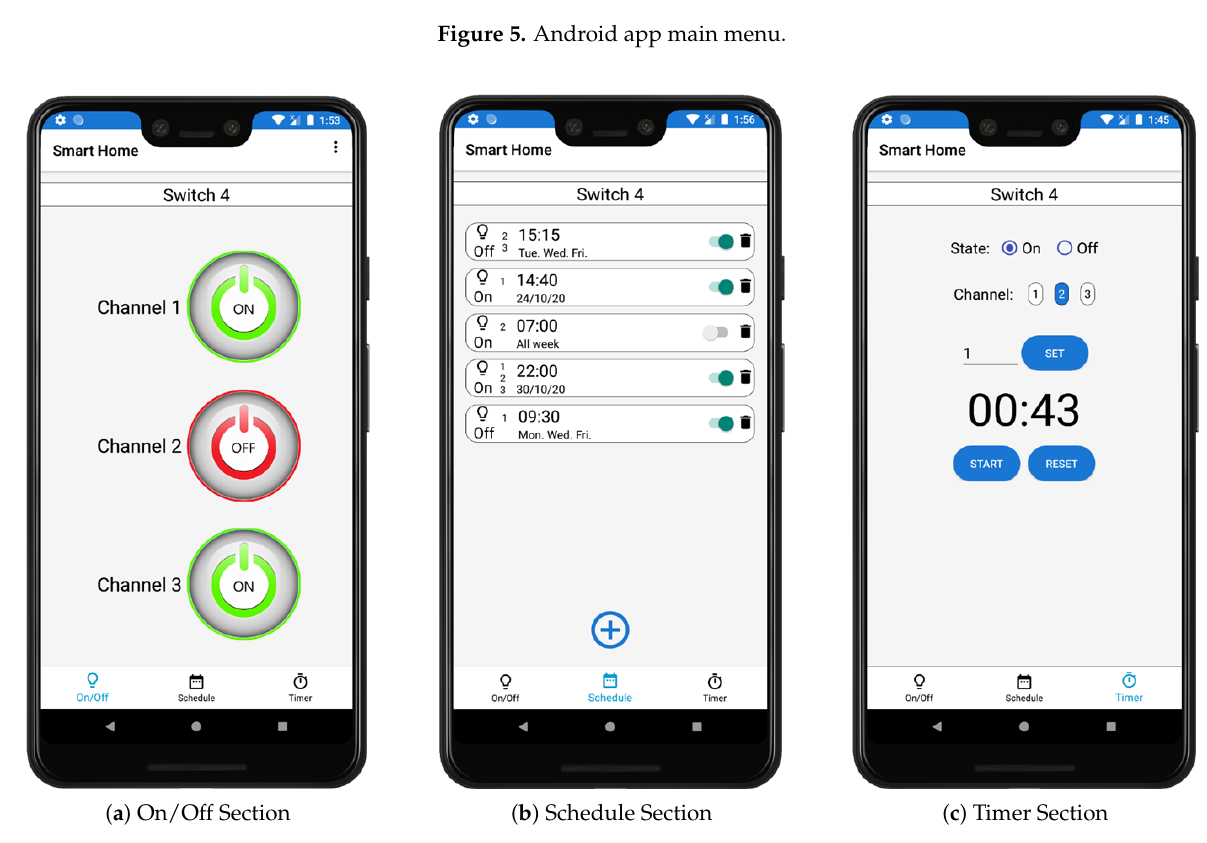
Figure 6. Android app device